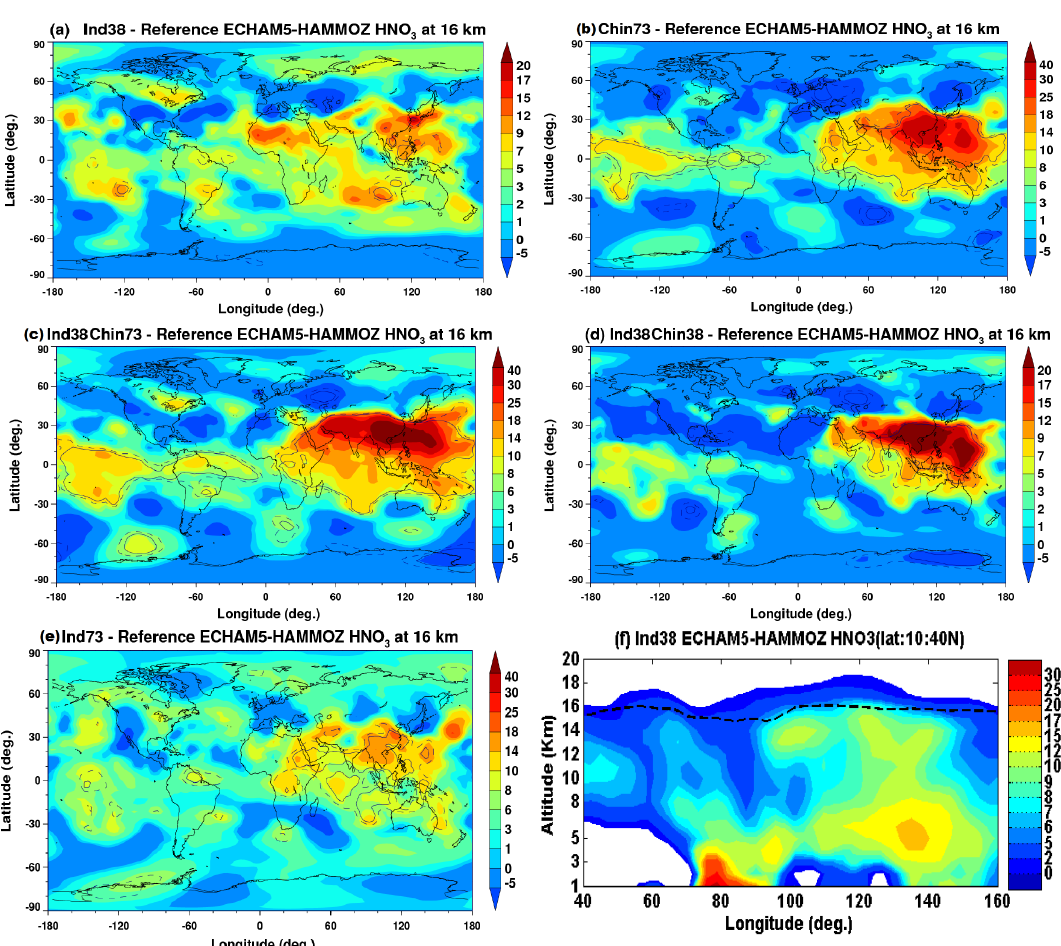
Figure 7. Percentage change in ECHAM5-HAMMOZ HNO 3 at 16km, as obtained from (a) Ind38, (b) Chin73, (c) Ind38Chin73, (d) Ind38Chin38 and (e) Ind73 simulations. Solid black line indicates the 95% Student’s t test confidence interval while the dashed line indicates 90% confidence interval (f) Longitude–altitude cross section (averaged over 10–40 ◦ N) of percentage change in HNO 3 for the Ind38